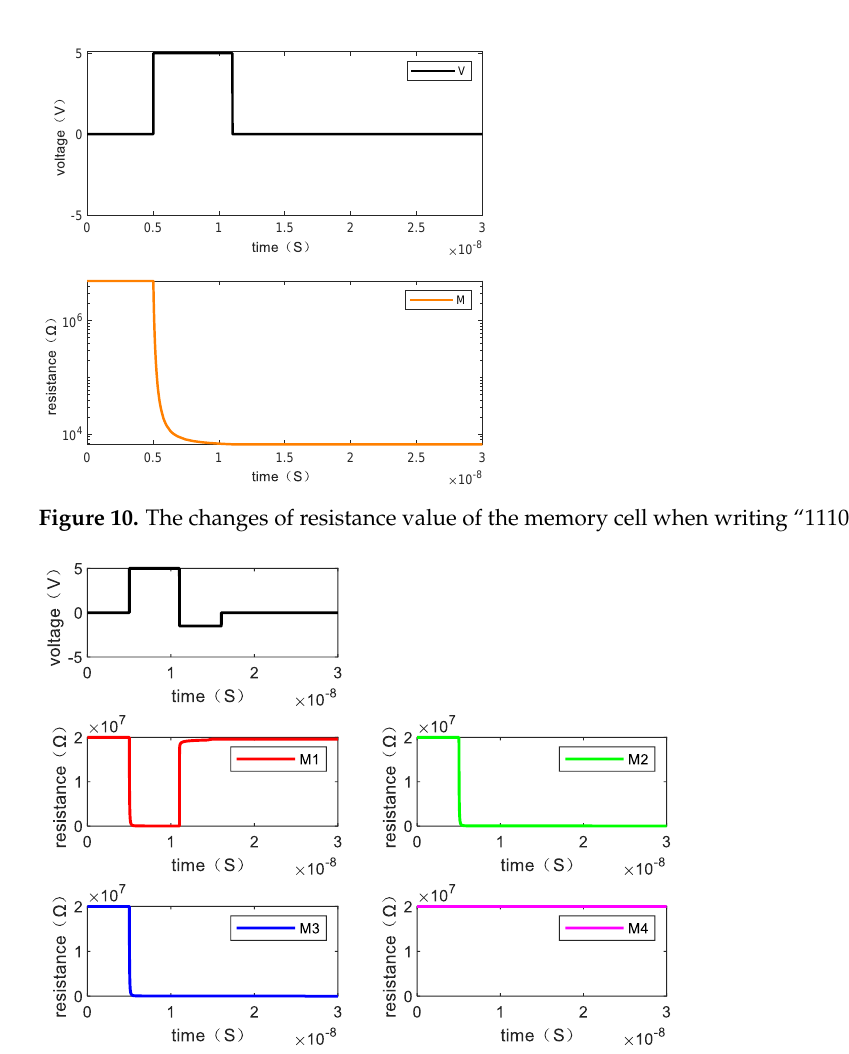
Figure 11. The resistance value of each memristor changes when writing “0110”.